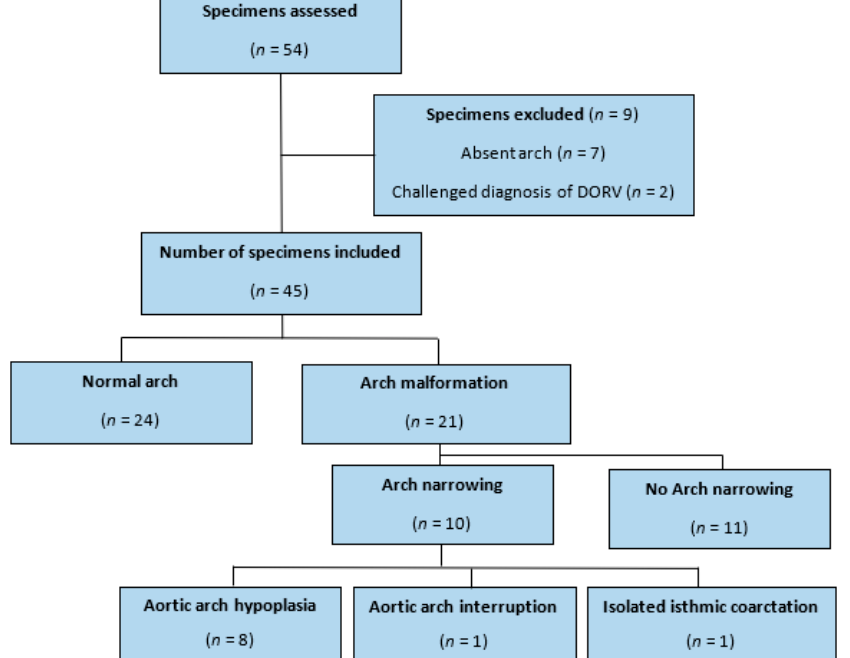
Figure 2. Study profile. Specimens with arch malformations showed one or multiple from: a right arch; mirror image branching pattern of epi-aortic branches; presence of aberrant branch(es); common or trunk origin of branch(es); arch narrowing. Narrow arches showed one or multiple from: aortic arch hypoplasia; isolated isthmic coarctation; aortic arch interruption.